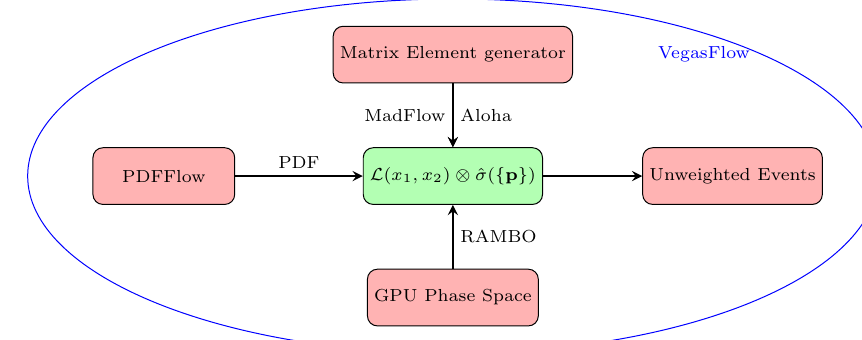
Fig. 1 Schematic workflow